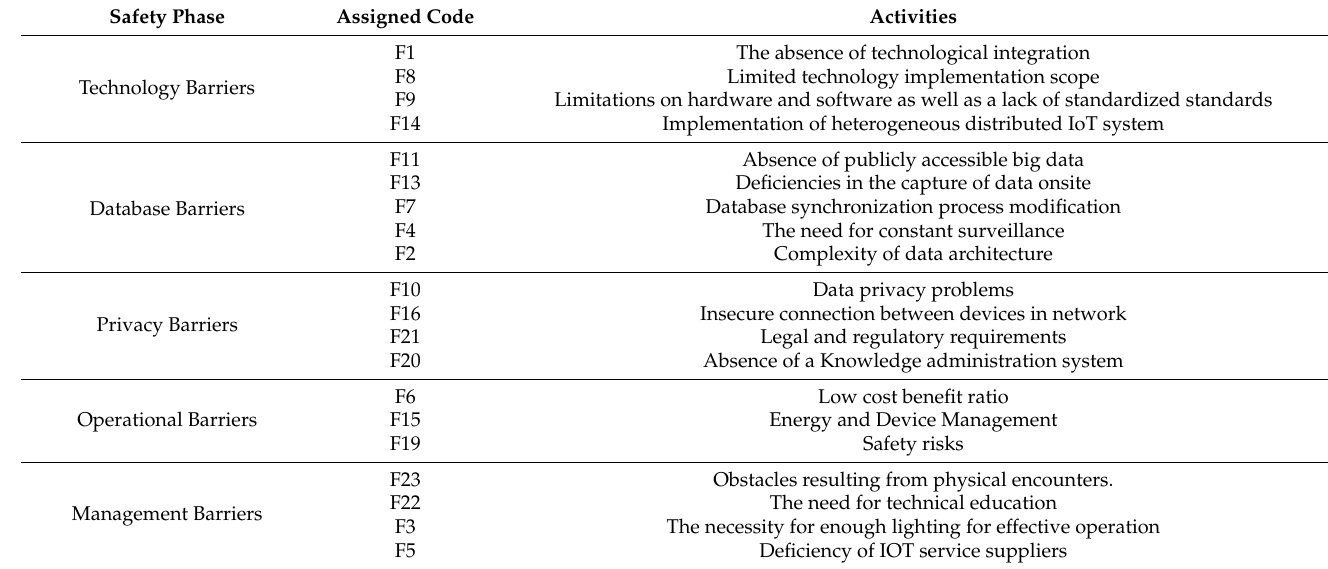
Table 4. Categorization of factors generated from